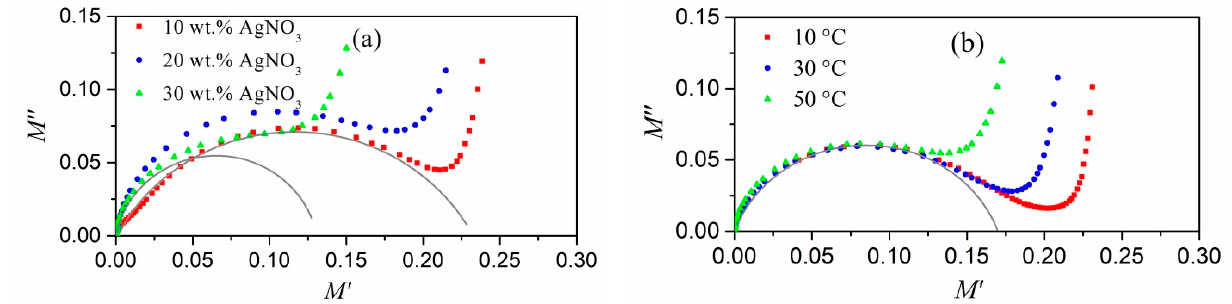
Figure 4. The plot of the Cole–Cole equation at T = 60 °C for Ag/PAN nanocomposites prepared from a mixture with different concentrations of silver nitrate ( a ) and for a Ag/PAN nanocomposite prepared from a mixture with 20 wt.% of AgNO 3 and 15 wt.% of PI at different temperatures of measurement ( b ). The solid lines represent approximating curves according to the Cole–Davidson model.